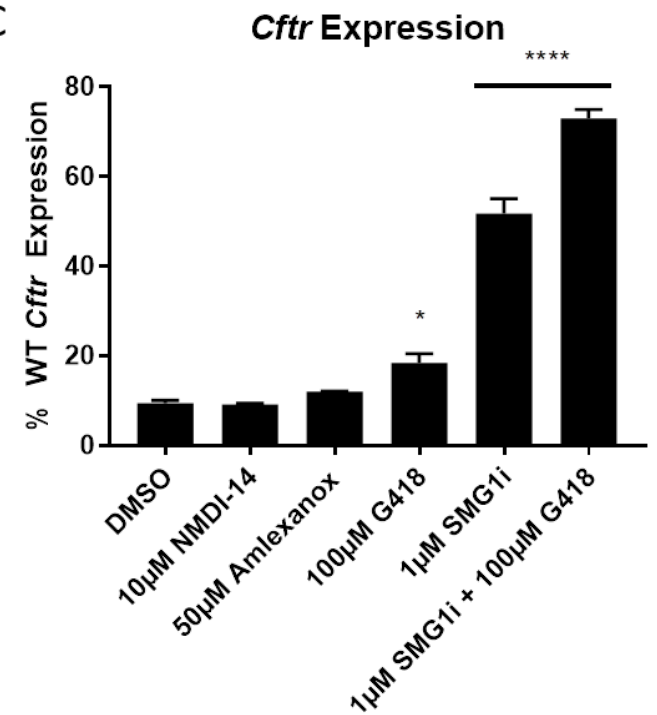
Figure 2. SMG1i, but not NMDI-14 or amlexanox, synergizes with G418 to improve CFTR function. ( A ). Normalized FIS curves of G542X intestinal organoids treated with indicated doses of SMG1i with or without 100 µ M G418. n = 3. ( B ). AUC values for the indicated doses of SMG1i, NMDI-14, and amlexanox with or without 100 µ M G418. * p < 0.001 vs. DMSO: DMSO by ANOVA with a post-hoc Tukey test. ( C ). Cftr mRNA expression in organoids treated for 24 h with the indicated doses of NMDI-14, amlexanox, G418, and SMG1i. Displayed as a percentage of WT Cftr expression. * p < 0.01, **** p < 0.0001 by 1 way ANOVA with post-hoc Tukey test. n = 3 experiments per group.